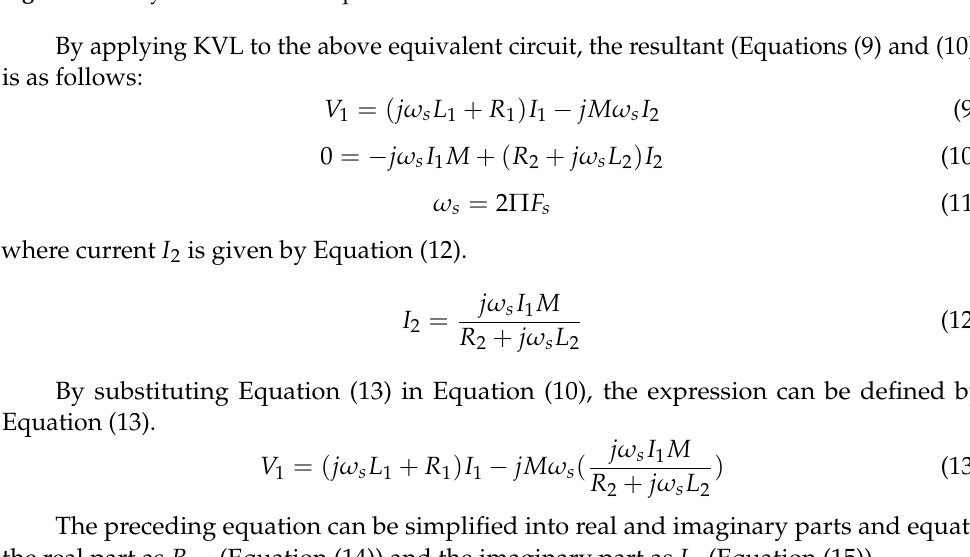
Figure 10. IH system’s electrical equivalent load model.